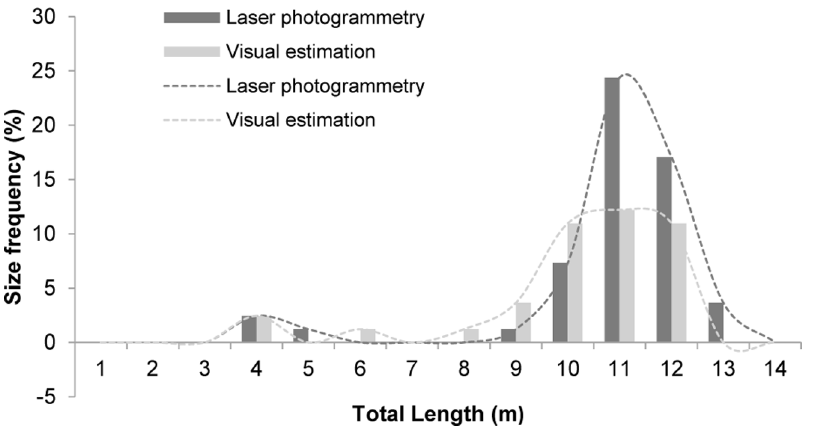
Fig. 4. Size-frequency distribution. Size measurements by laser photogrammetry (N 5 47; dark grey bars and dotted line) and visual estimation (N 5 35; light grey bars and dotted line) of the 82 whale sharks photo- identified at Darwin Island, Galapagos Marine Reserve, between 2011 and